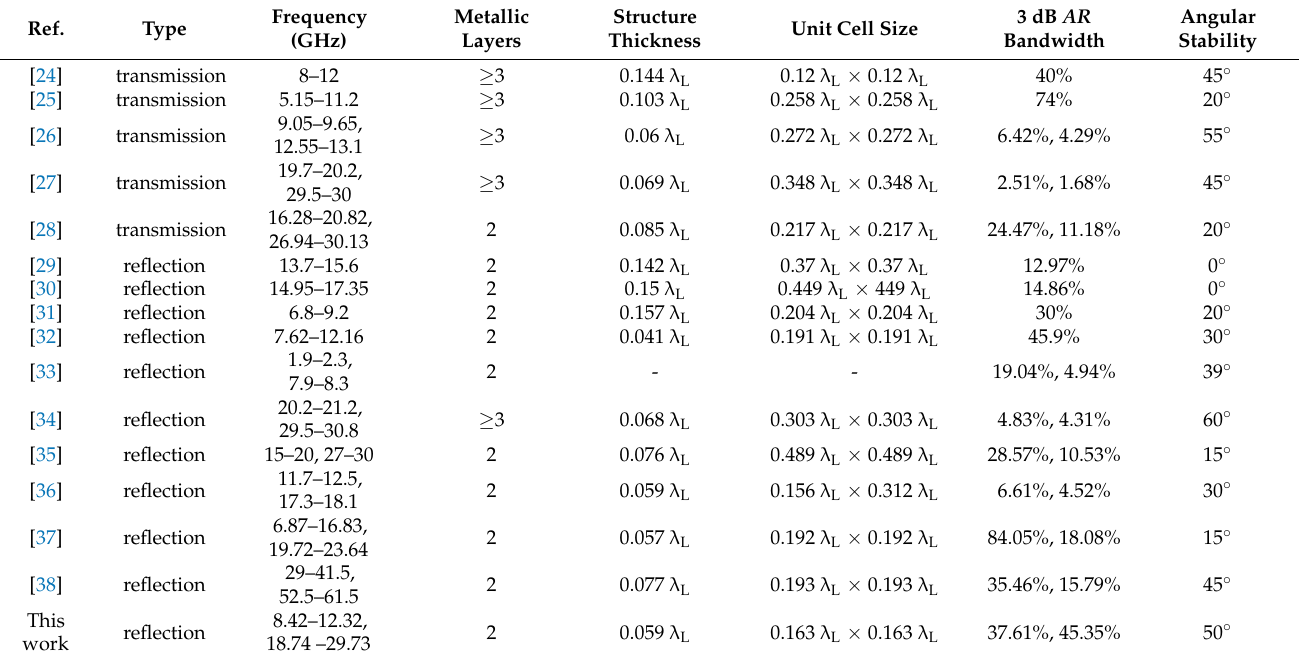
Table 1. Performance comparison of polarization converters in the